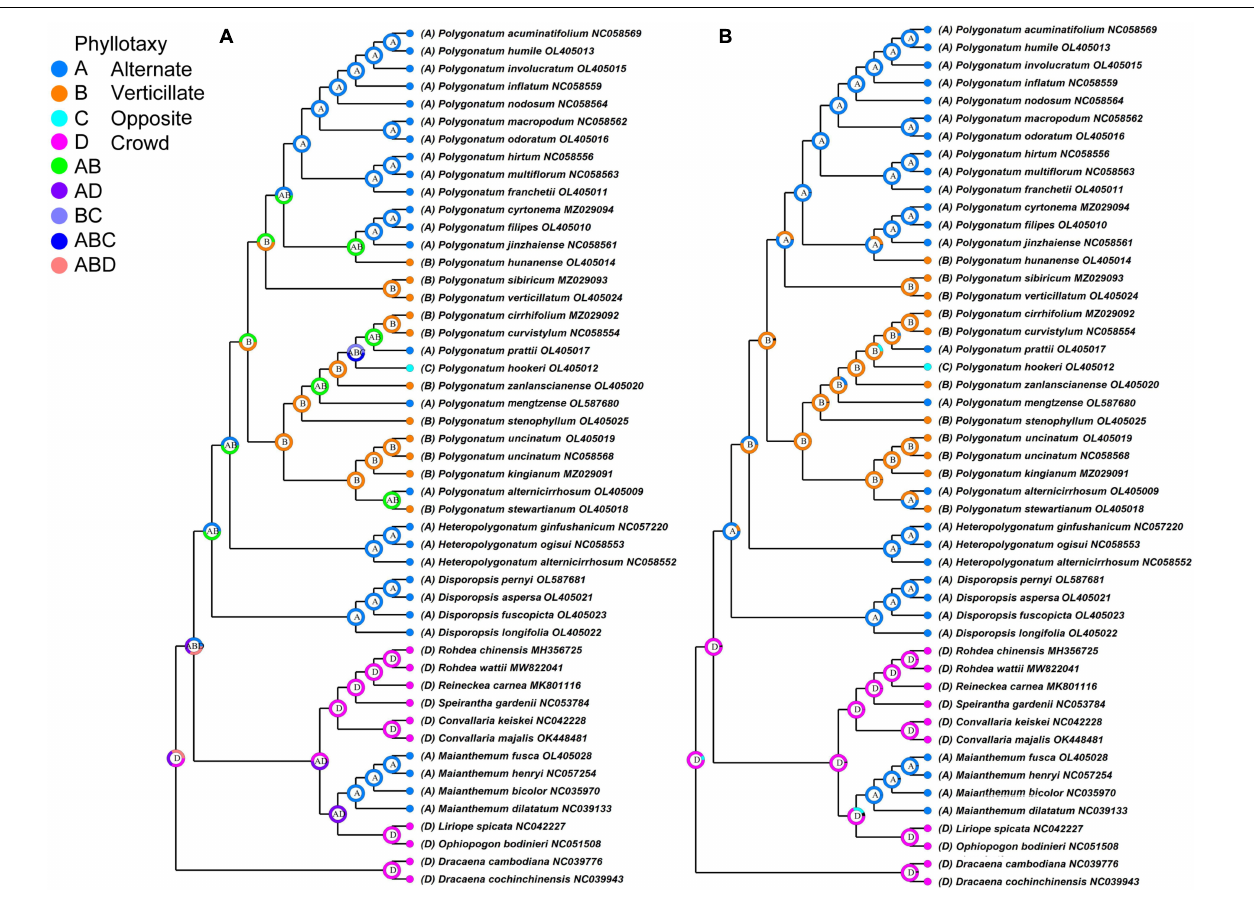
FIGURE 6 | Ancestral state reconstructions of leaf arrangement in genus Polygonatum. (A) S-DIVA method and (B) MRBT